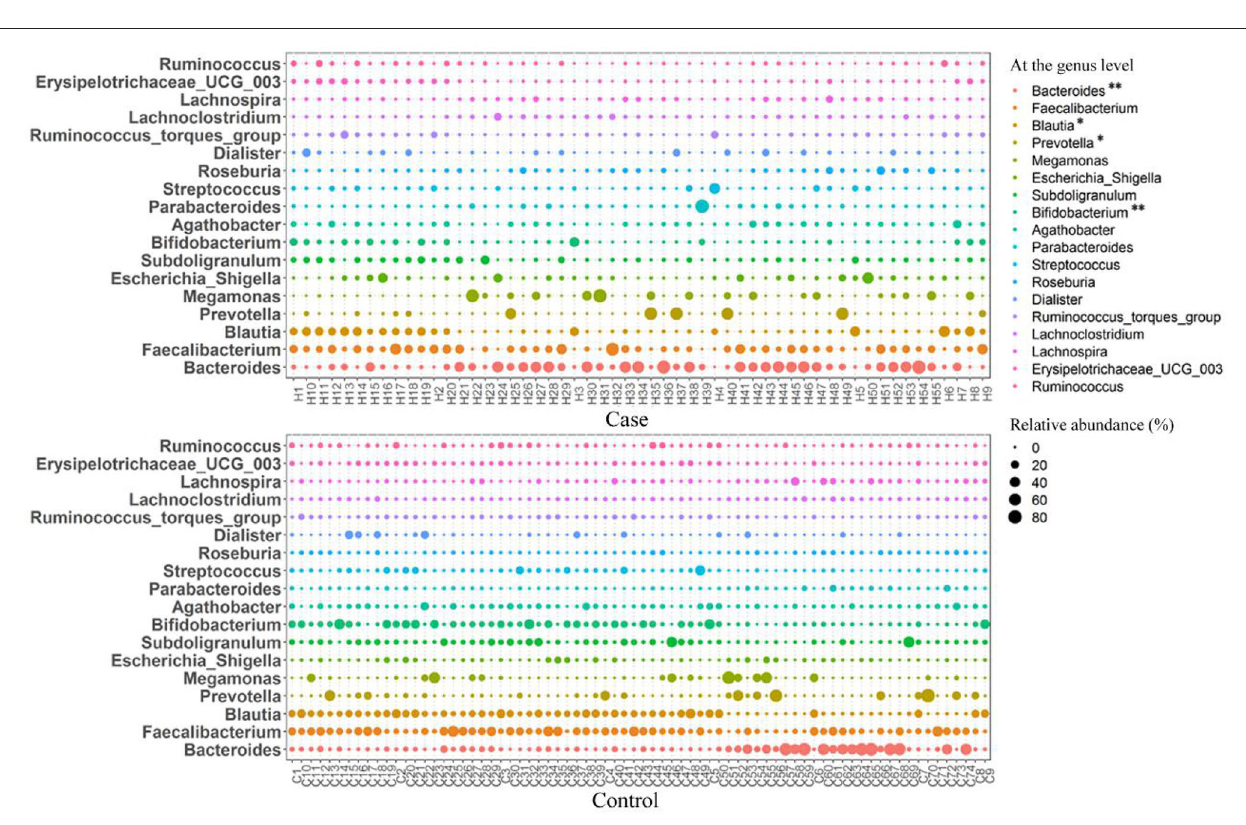
FIGURE 5 | Bubble diagram of the relative abundance of gut microbiota at the genus level between the two groups. * p < 0.05, ** p <